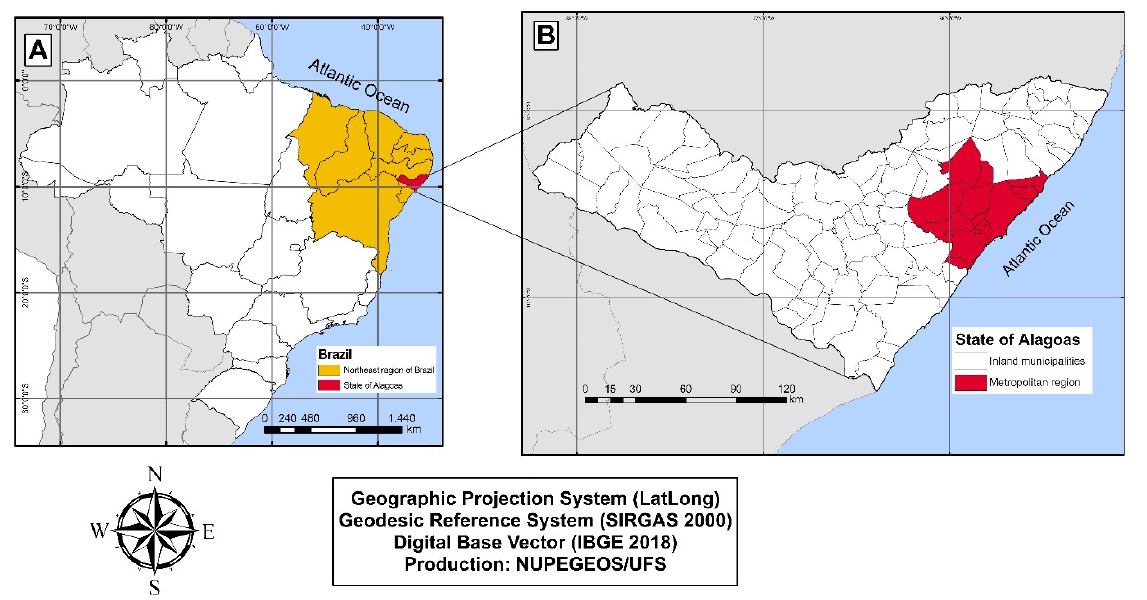
Figure 1. Map of the study area. ( A ) Map of Brazil highlighting the Northeast region (in yellow) and highlighting the state of Alagoas (in red). ( B ) Map of the state of Alagoas divided into metropolitan region (in red) and inland municipalities (in white).